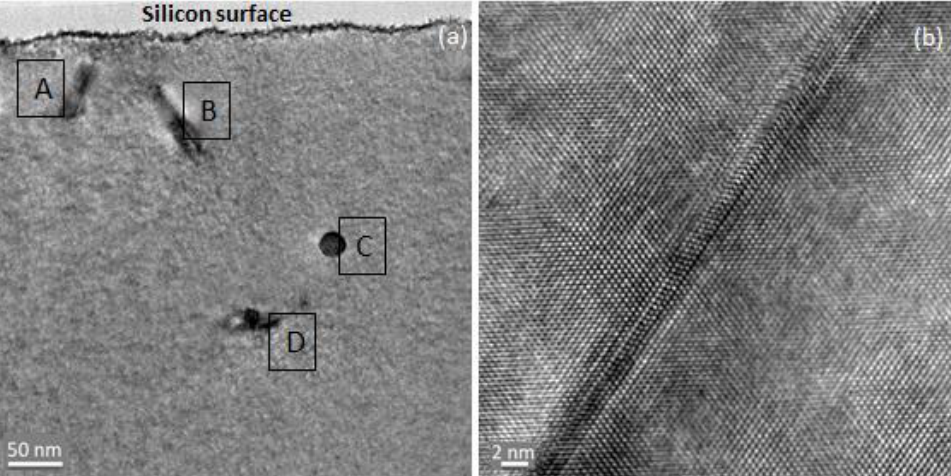
Figure 9. TEM analysis for ( a ) sample G implanted with 30/10 keV of carbon and 10 keV of boron ions and ( b ) for point A. The defects A and B can be clearly seen at the depths of 100 nm and 200 nm. The defects C and D are the deep-level trap.